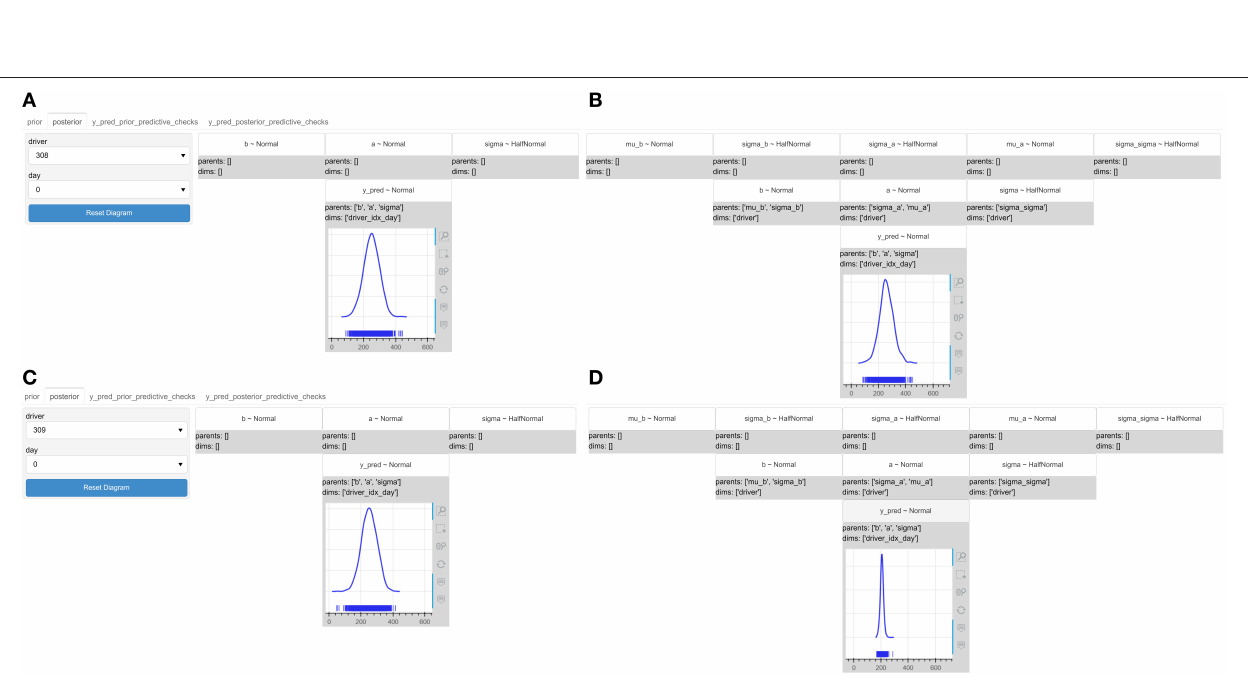
FIGURE 8 | The interactive probabilistic models explorer of the reaction times models, where we set the driver to 308 and 309 and observe the posterior predictive distribution of the reaction times on the same day of driving for the pooled and hierarchical model. The posterior predictive distribution of the reaction times (A) for driver 308 in the pooled model, (B) for driver 308 in the hierarchical mode, (C) for driver 309 in the pooled mode, and (D) for diver 309 in the hierarchical model. The pooled model does not reveal significant differences among drivers.